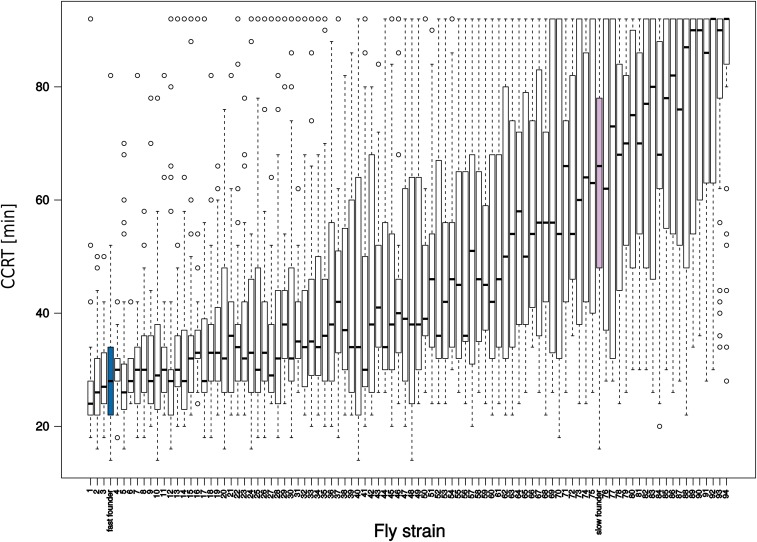
Chill coma recovery time (CCRT) of 4 - 6 day old virgin female flies of the 94 recombinant inbred advanced intercross lines (RIAILs) and the two founder strains. CCRT of the RIAILs is displayed with white bars. CCRT of the two founder strains is displayed in blue (Fast founder) and pink (Slow founder) (see also Figure 2). The RIAILs were numbered in ascending order according to their average CCRT. The fact that recovery times of 19 RIAILs exceeded the recovery time of the Slow founder strain suggests non-additive effects at causal loci.